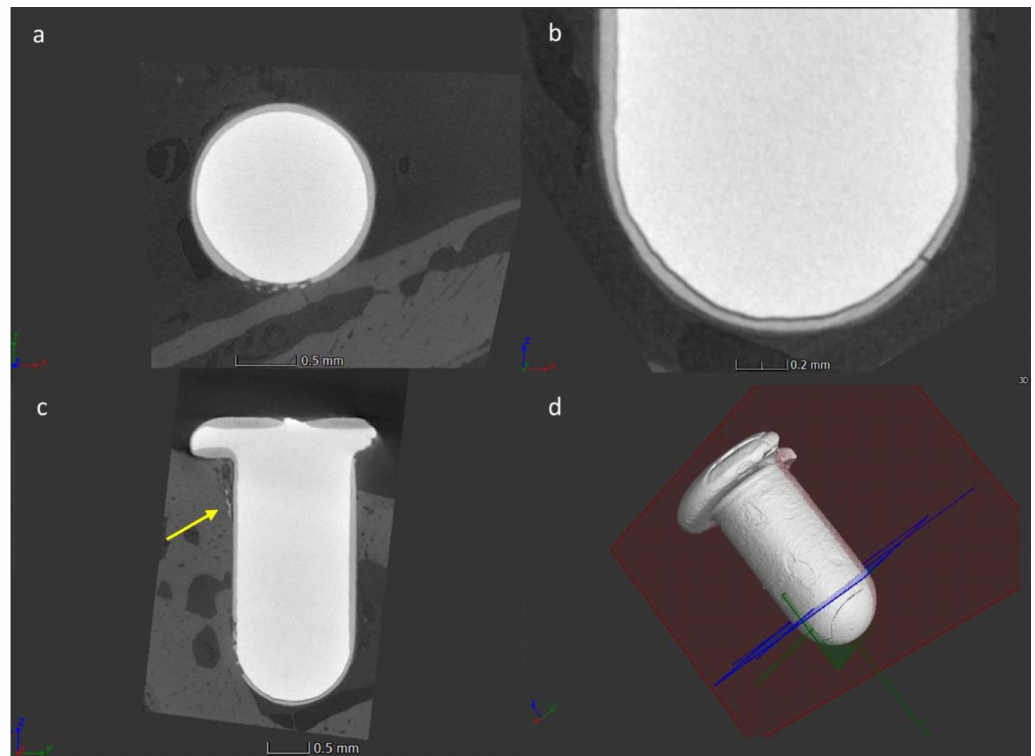
Figure 8. Micro-CT images of the sphene-coated implant presenting a partial delamination and disintegration of the bioceramic coating: ( a ) a transverse cross-sectional view; ( b ) a detail of the apical part of the implant; ( c ) a cross-sectional view parallel to the long axis of the implant, debris are indicated by the yellow arrow; ( d ) a 3D voxel-based reconstruction.